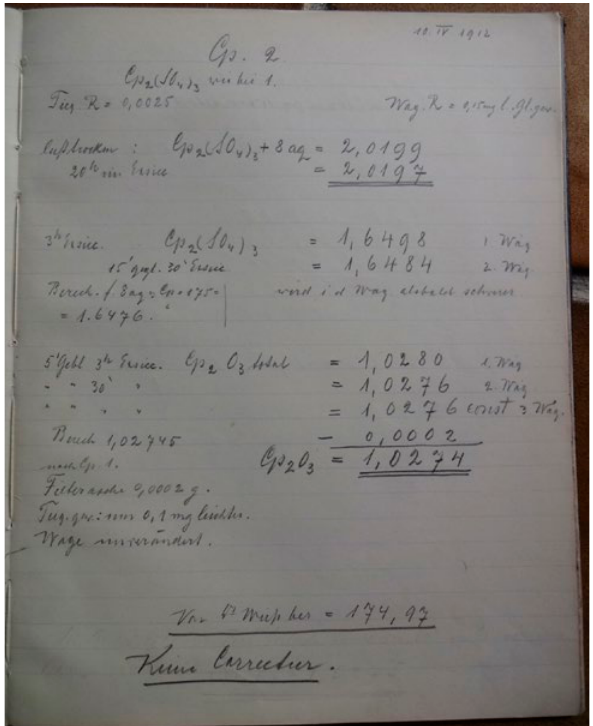
Figure 9. Lutetium (Cp), atomic weight determination, second to last step 1912.